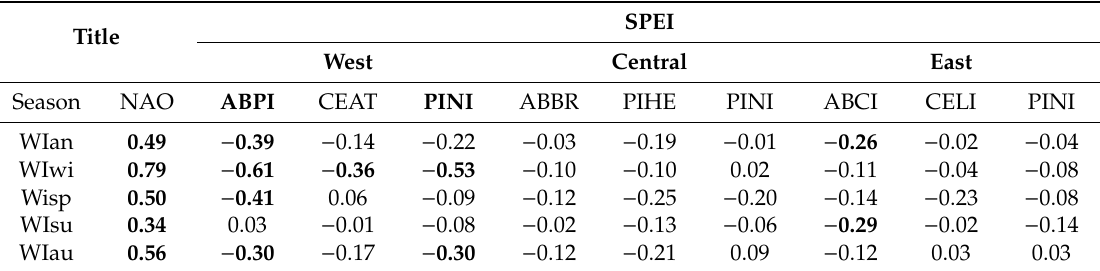
Figure 2. Field correlations for the period 1901–2001 calculated between winter North Atlantic Oscillation (DJF NAO, upper panel) and annual Westerly Index (WI, lower panel) and winter 3-month Standardized Precipitation–Evapotranspiration Index (SPEI3). Squares in the upper panel are study sites (see codes in Figure 1). Table 2. Correlation matrix of the seasonal (wi, winter; sp, spring; su, summer; au, autumn) and annual WI (dependent variable) versus annual NAO and annual SPEI3 for each of the nine di ff erent sites for 1946–2010. Correlation values in bold letters are significant at the p < 0.05